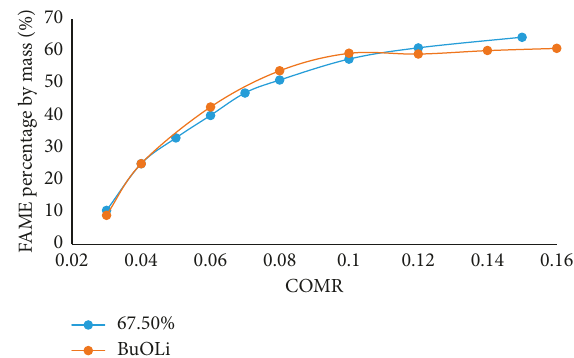
Figure 4: The conformity of experimental COMR-FAME with the simulated one by ion-pair dissociation constant 0.005608 (67.5% dissociation degree at COMR (cid:31)